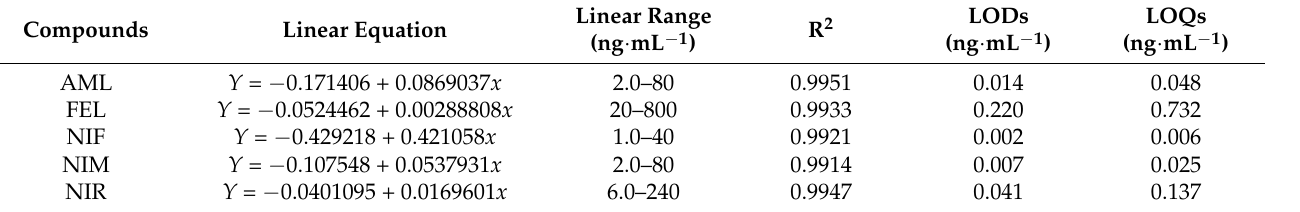
Table 1. Regression equations, LODs, and LOQs of compounds.